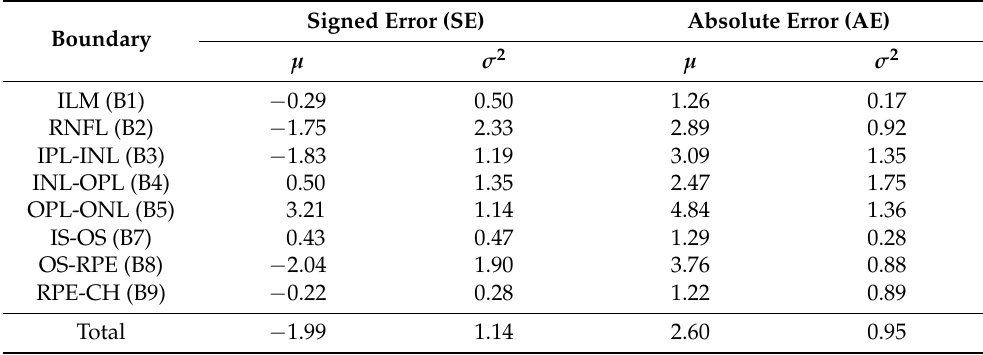
Table 2. Assessing the segmentation of healthy